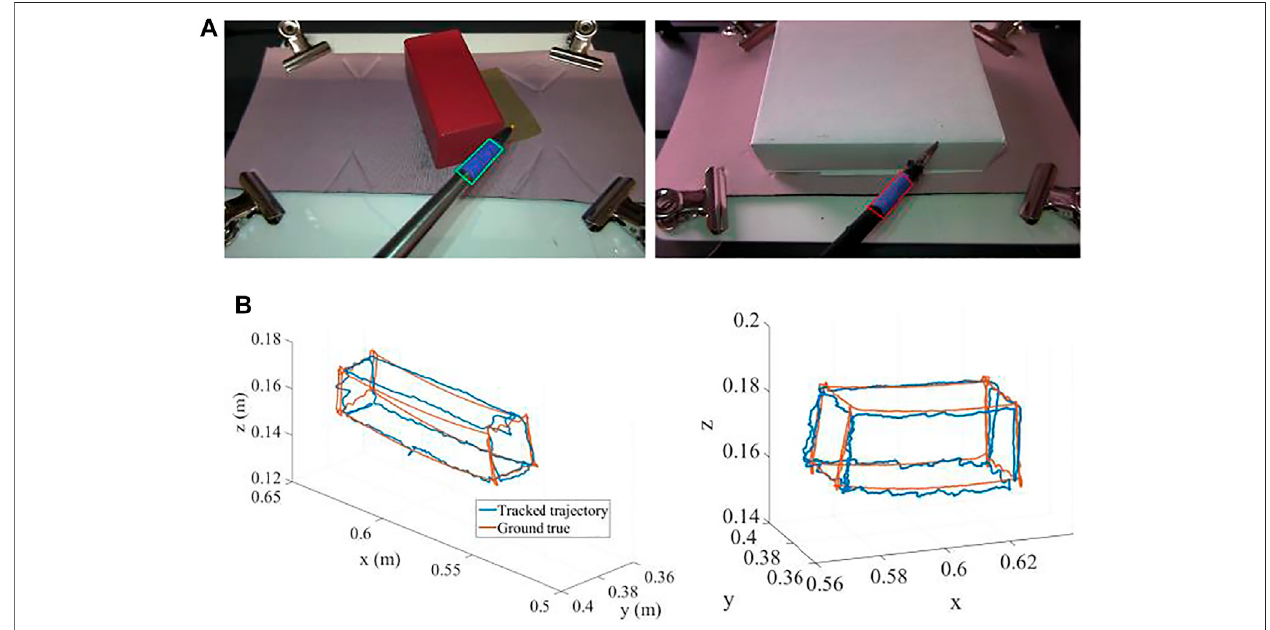
FIGURE 11 | (A) Two sample boxes used to generate the trajectories. (B) The trajectories generated by the robot (red) and tracked by the real-time image processing algorithm (blue) (units: m).